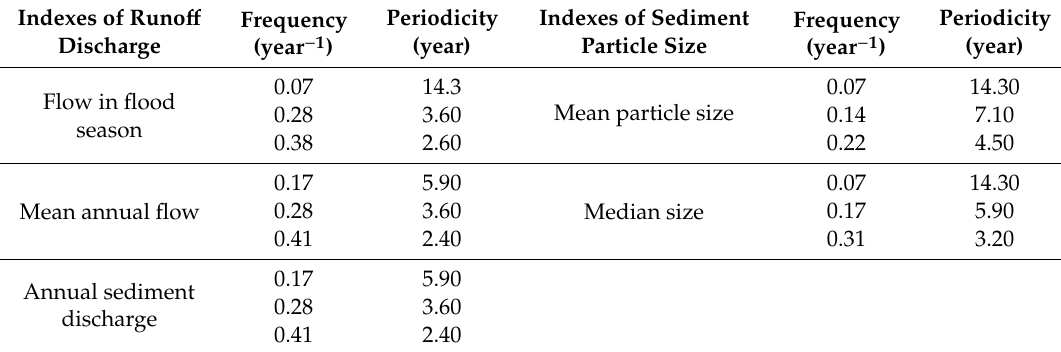
Table 1. Cycle analysis of Liaohe runo ff index and sediment particle size parameters of tidal flat sediments in Liaohe estuary